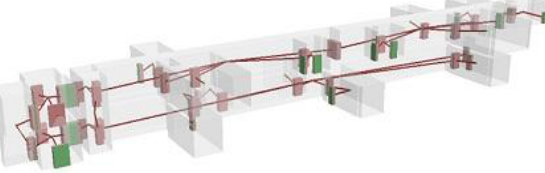
Figure 10. 3D semantics building model contains floor, rooms, doors, and stairs geometries.